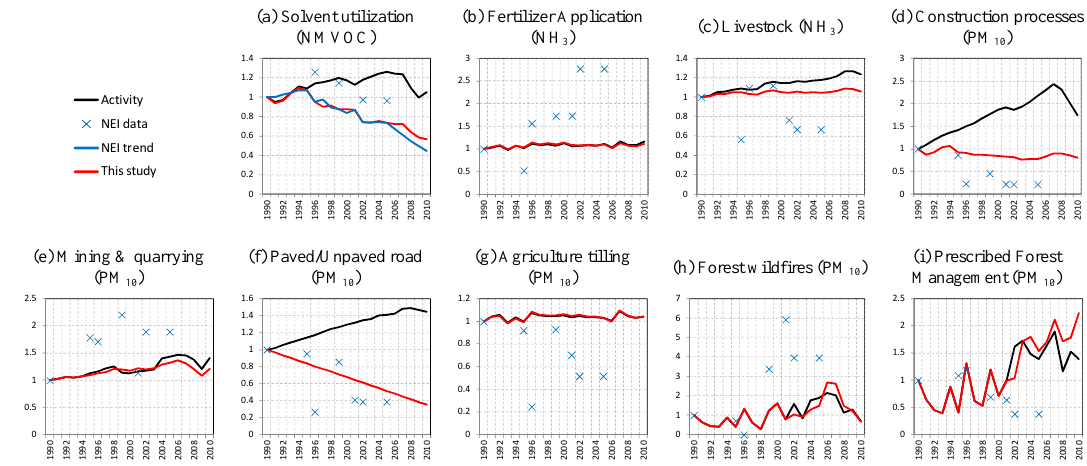
Fig. 7. Activity and emission trends during 1990–2010 for other non-energy-related sources (year 1990 = 1; absolute values are provided in Fig. 7 Activity and emission trends during 1990-2010 for other non-energy related sources (Year 1990=1, absolute values are provided Table in Table S2d)